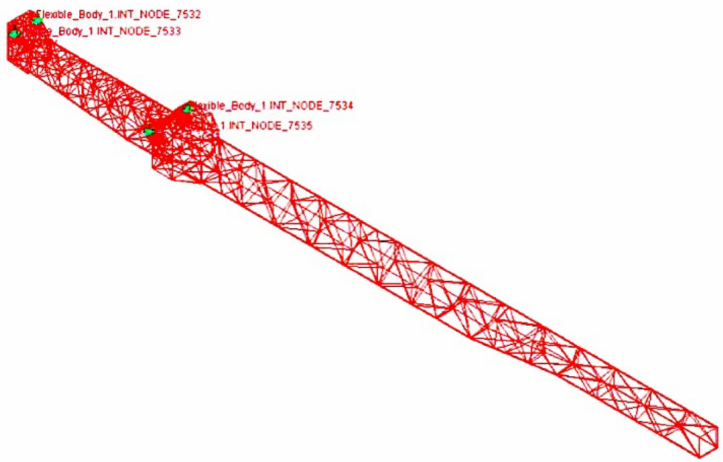
Figure 6. The finite element model of a mechanical arm.